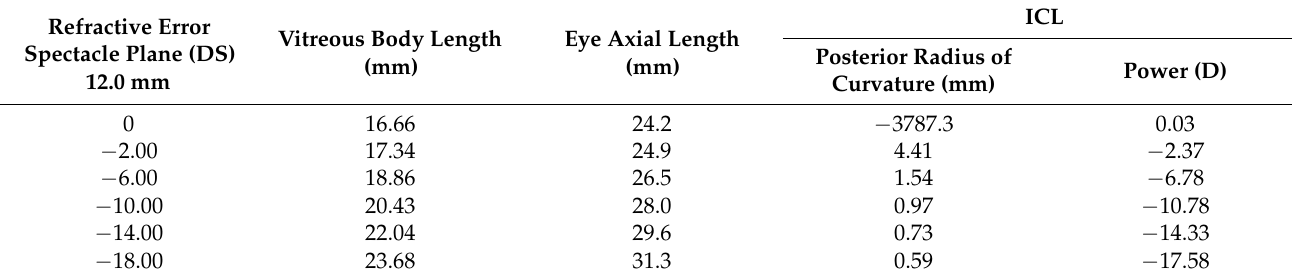
Table 4. Shows the parameters used to generate a series of myopic model eyes. Refractive Error, Vitreous Body Length, ICL Posterior Radius Curvature are defined in the model eye as variables. Refractive Error Spectacle Plane